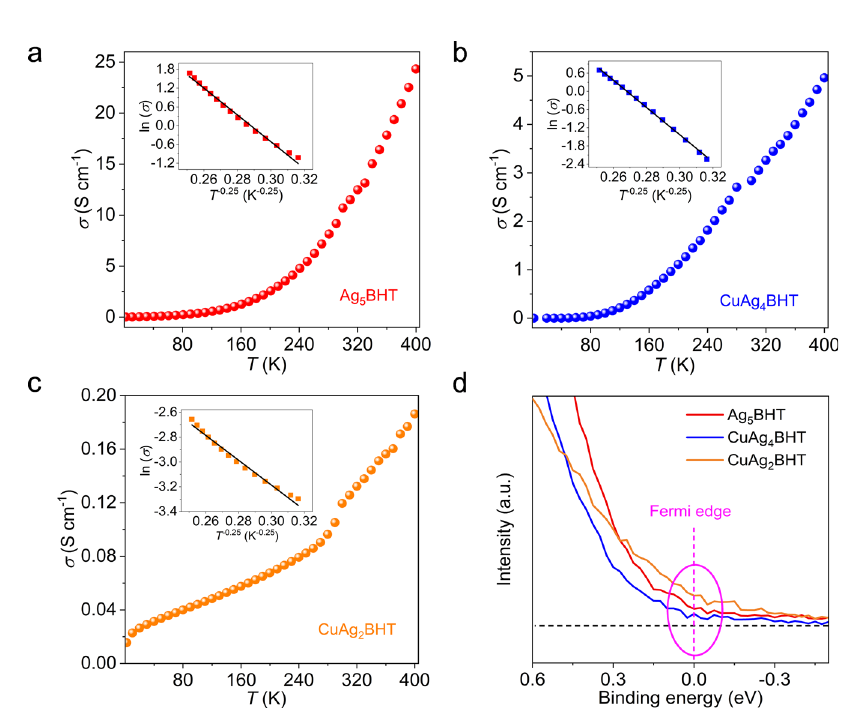
Fig. 4 | Electrical transport characterizations. a – c Electrical conductivities of three materials as a function of temperature from 2 to 400K. Inset, plots of ln( σ ) versus T − 1/4 over the temperature region of 100 – 250K. d UPS data for the valence